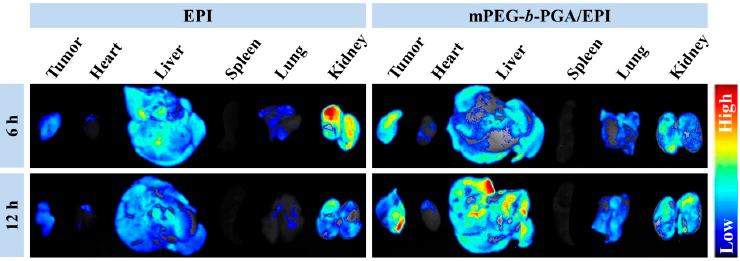
Figure 8. Ex vivo EPI fluorescence images showing tissue distribution of free EPI and mPEG- b -PGA/EPI in tumors and major organs ( i.e. , heart, liver, spleen, lung, and kidney) of H22 HCC-xenografted BALB/c mice at 6 or 12 h post-injection ( n = 3).